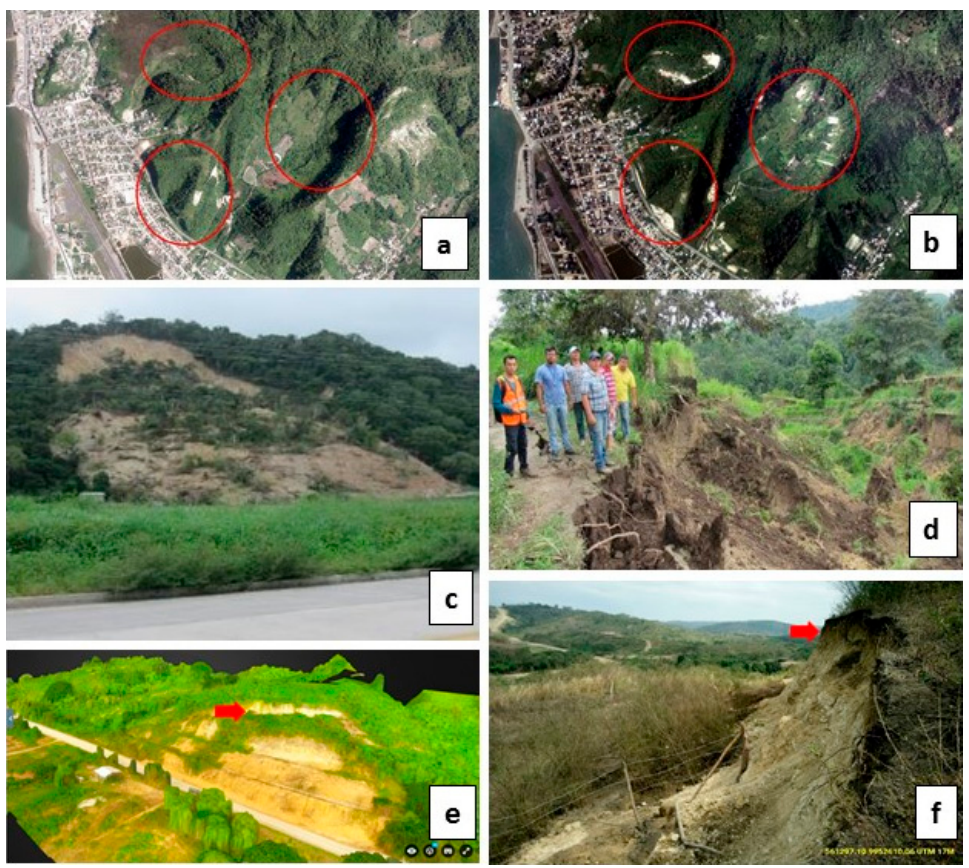
Figure 4. Example of coherent landslides: a ) and b ) pre- and post-earthquake satellite imagery at San Vicente, provided by the Web-GIS of the Military Geographical Institute of Ecuador (IGM) (VIII ESI-07 ); c ) rotational landslide at Briceño site, volume less than 3200 m 3 , tree cover fall, active slope (VIII ESI-07 ); d ) rotational landslide at San Isidro, soil cracks 10 to 20 meters wide in soil, rotational landslides ca. 60 m long (IX ESI-07 ); e ) and f ) stabilized slope also reported damage in the epicentral area, northern of Canoa site, where part of the hillslope was displaced by landslide of ca. 400 m 3 (drone imagery courtesy of by Global Medic and Servicio Nacional de Gestión de Riesgo y Emergencias de Ecuador), (VIII ESI-07 ); locations on Figure 2.